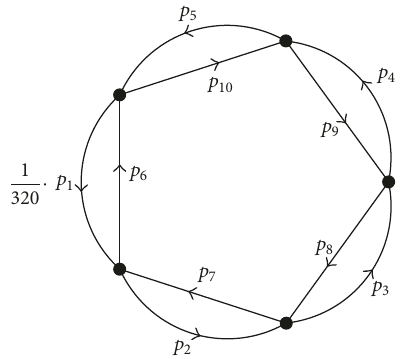
Figure 4: The first and most symmetric 2PI six-loop diagram (symmetry factor 1/320 , 𝑅 = 17/3888 = 0.0044 ).